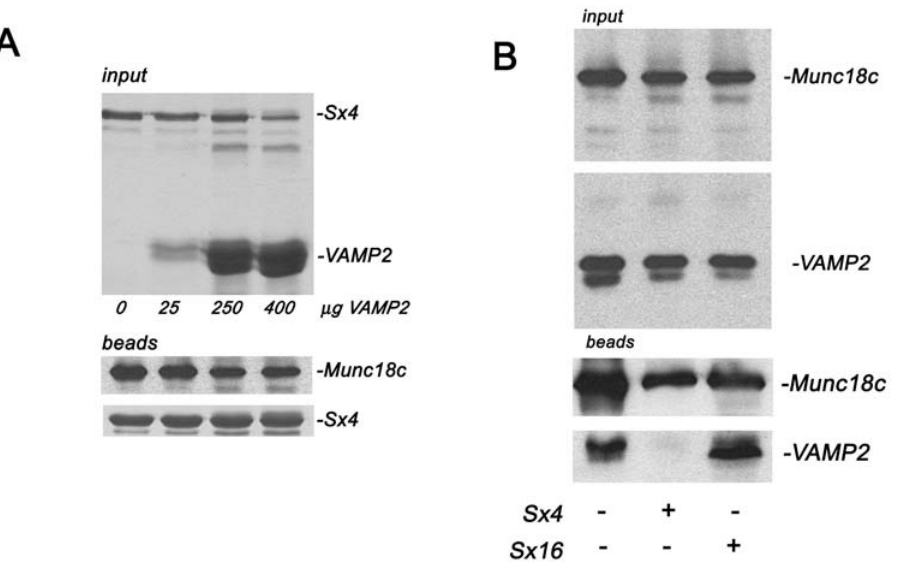
Figure 3. Syntaxin 4 disrupts the interaction of Munc18c with VAMP2. (A) 5 m g of M18c was immobilised on Ni-NTA agarose and incubated overnight with an excess (10 m g) of Sx4 cytosolic domain (residues 1–273) (final concentration 0.7 m M Munc18c, 3.3 m M Sx4 in the initial incubation). After extensive washing, the pre-formed complex was subsequently incubated with increasing concentrations of VAMP2 cytosolic domain (residues 1–92) as indicated. Upper panel shows a Coomassie stained gel of the input proteins; lower panel shows an immunoblot of the beads probed with anti-Munc18c, or stained with Coomassie to show levels of Sx4. (B) 5 m g of M18c was immobilised on Ni-NTA agarose and incubated overnight with an excess (10 m g) of VAMP2 cytosolic domain (final concentration 0.7 m M Munc18c, 7 m M VAMP2 in the initial incubation). The upper panel (input) shows an immunoblot analysis of these beads after extensive washing confirming the presence of both Munc18c and VAMP2. This preformed complex was then incubated alone or with 250 m g of Sx4 cytosolic domain or (as a control) 250 m g Sx16 cytosolic domain (residues 1–269) (both t- SNAREs at a final concentration 16.7 m M), as indicated. Immunoblot analysis was again used to determine the amount of Munc18c and VAMP2 that remained bound following this challenge (lower panel). Data shown are representative of three experiments of this